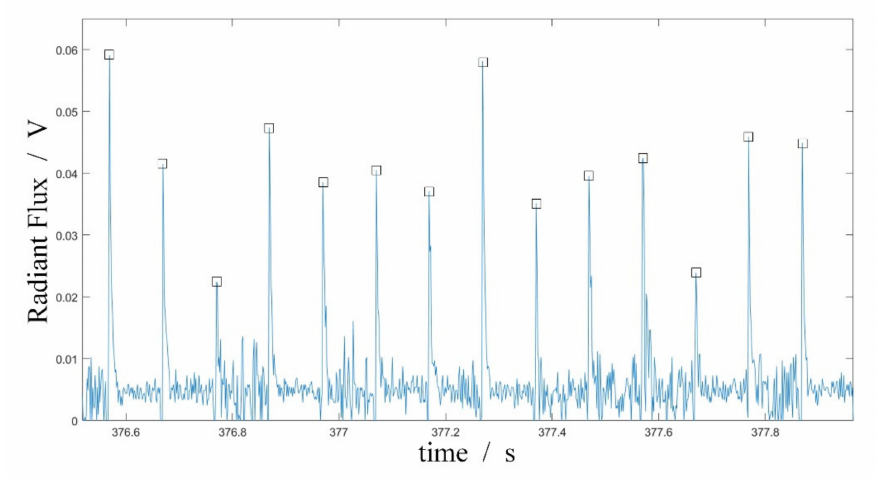
Figure 10. Radiation flux of reflected laser.